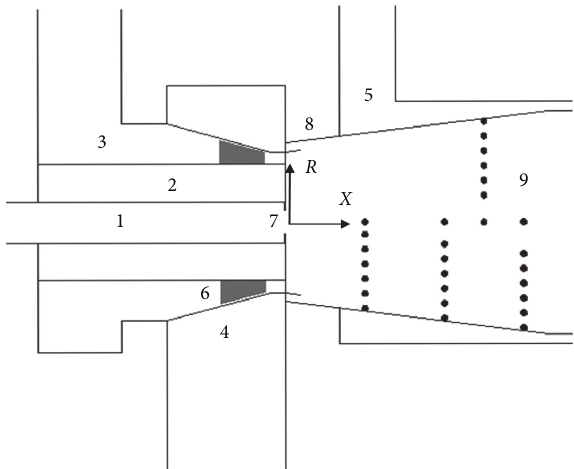
Figure 2: Schematic diagram of the swirl burner with the pre- chamber. 1-primary air duct; 2-isolate duct; 3-inner secondary air duct; 4-outer secondary air duct; 5-tertiary air duct; 6-axial movable swirl vanes; 7-combustion stabilizing device; 8-expanding cone-shaped prechamber; 9-location of measuring points.